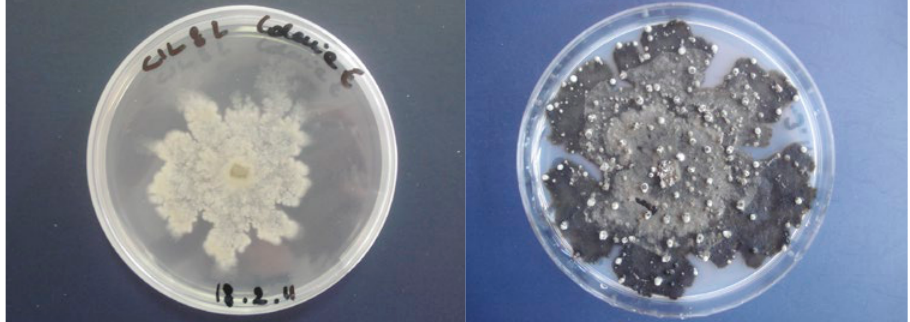
Figure 3. Isolate CIL8L of Leucostoma cinctum on potato dextrose agar, a 7-d-old colony (left) and a 2-month-old colony with pycnidia